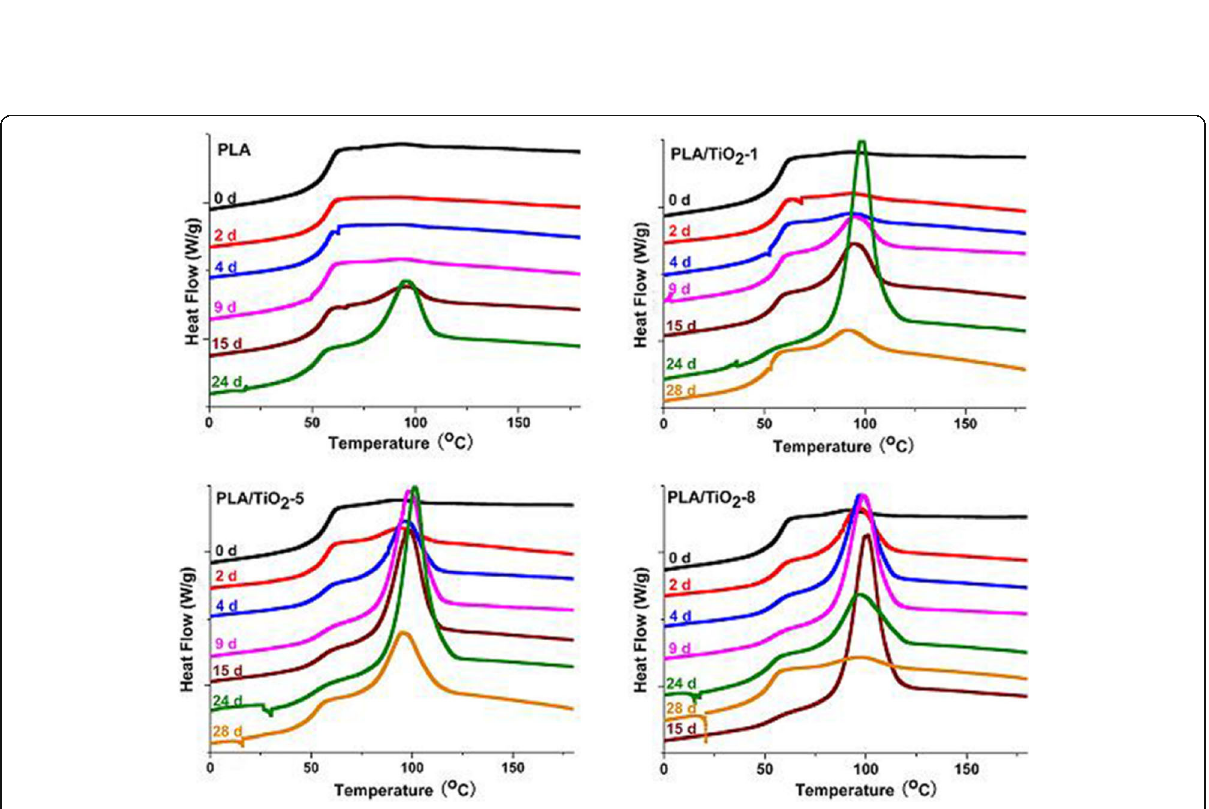
Fig. 3 DSC thermograms of biodegraded pure PLA and PLA/TiO 2 nanocomposites at different incubation times, cooling